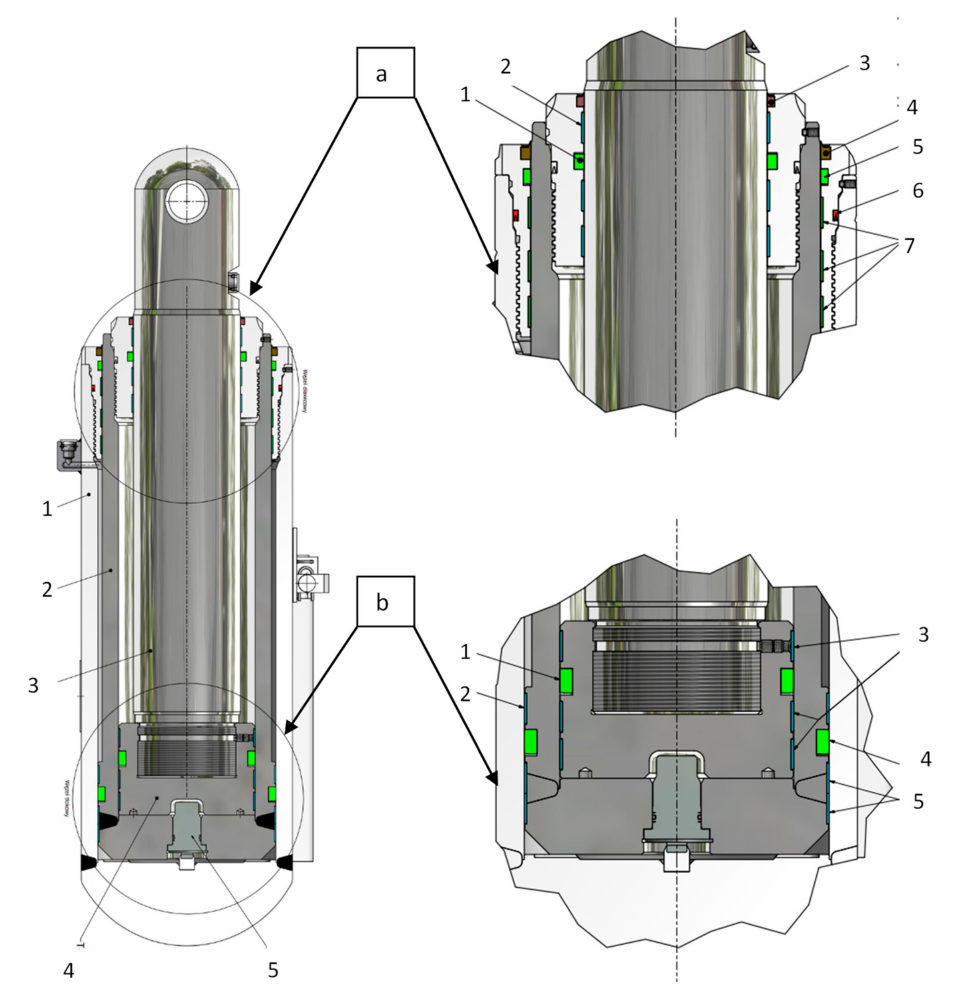
Figure 3. Conceptual diagram of the use of seals to protect the hydraulic prop from external and internal leakage, where 1—cylinder, 2—core I, 3—core II, 4—piston, and 5—bottom valve; ( a )